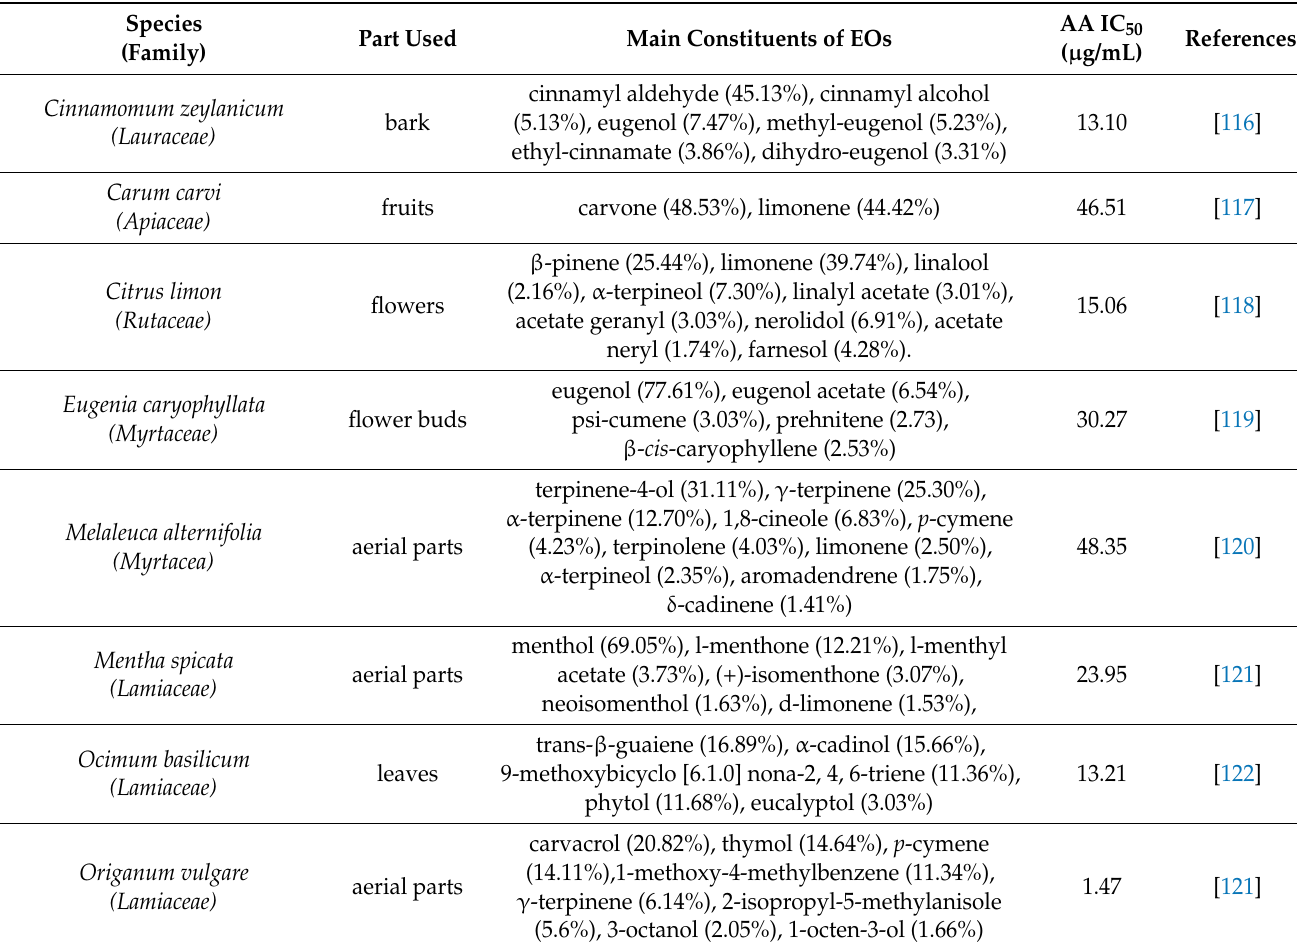
Table 5. Major natural compounds, and antioxidant activity of selected